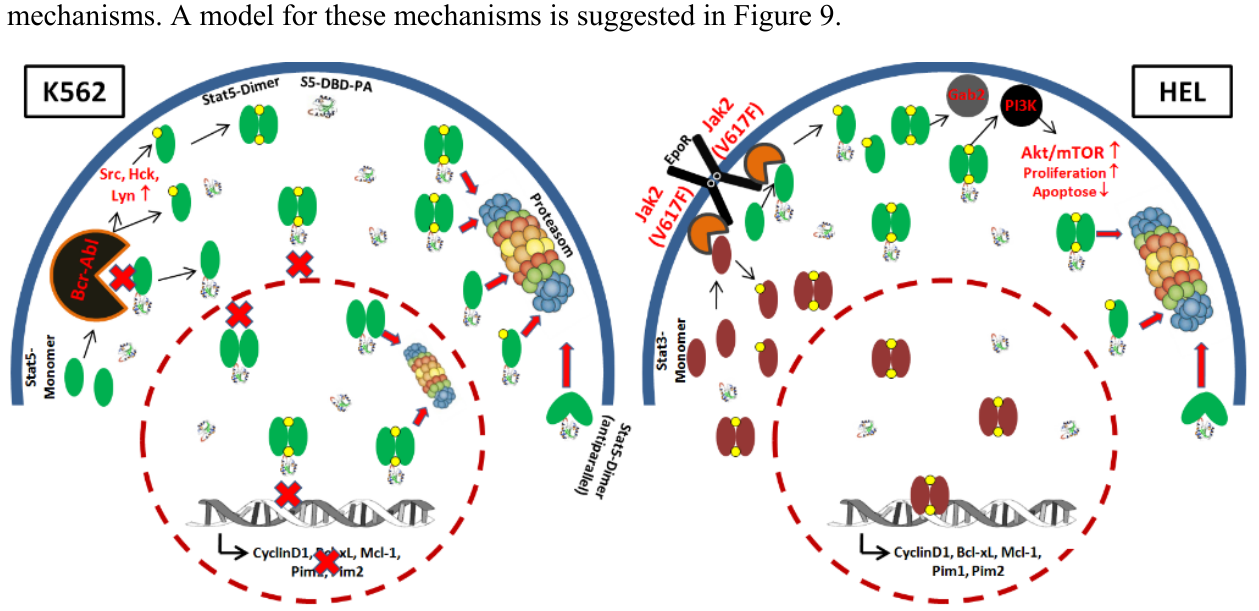
Figure 9. Model for the Stat5-regulated survival mechanisms in Bcr-Abl-transformed K562 and Jak2(V617F)-transformed HEL cells and the inhibitory functions of S5-DBD-PA of cytoplasmic and nuclear Stat5. Oncogenic Bcr-Abl causes the phosphorylation of Stat5 in the K562 CML cells. This can happen directly or indirectly via the activation of Src family kinases: Src, Hck, Lyn. Activated dimers of Stat5 subsequently translocate to the nucleus and drive the expression of growth promoting and antiapoptotic target genes. The interaction of S5-DBD-PA with the DBD of Stat5 interferes with DNA-binding and transcription, blocks the nuclear im- and export of active dimers and reduces tyrosine phosphorylation (phosphate groups are indicated by a yellow point) potentially through steric hindrance of complex formation between the enzyme and the substrate. It possibly causes an enhanced degradation of Stat5. The erythropoietin receptor (Epo-R) associated activity of mutant Jak2(V617F) is characteristic of Epo-hypersensitive PV and acute erythroid leukemia diseases [36]. In the HEL cell line, Stat5 and Stat3 monomers are phosphorylated by oncogenic Jak2(V617F) + independent of a S5-DBD-PA interaction. Active Stat5-dimer remain in the cytoplasm and promote essential PI3K-mediated survival pathways through cofactor interactions. The lack of nuclear Stat5 activity in HEL cells is accompanied by Stat3 activation and leads to a relatively higher resistance towards S5-DBD-PA when compared to K562